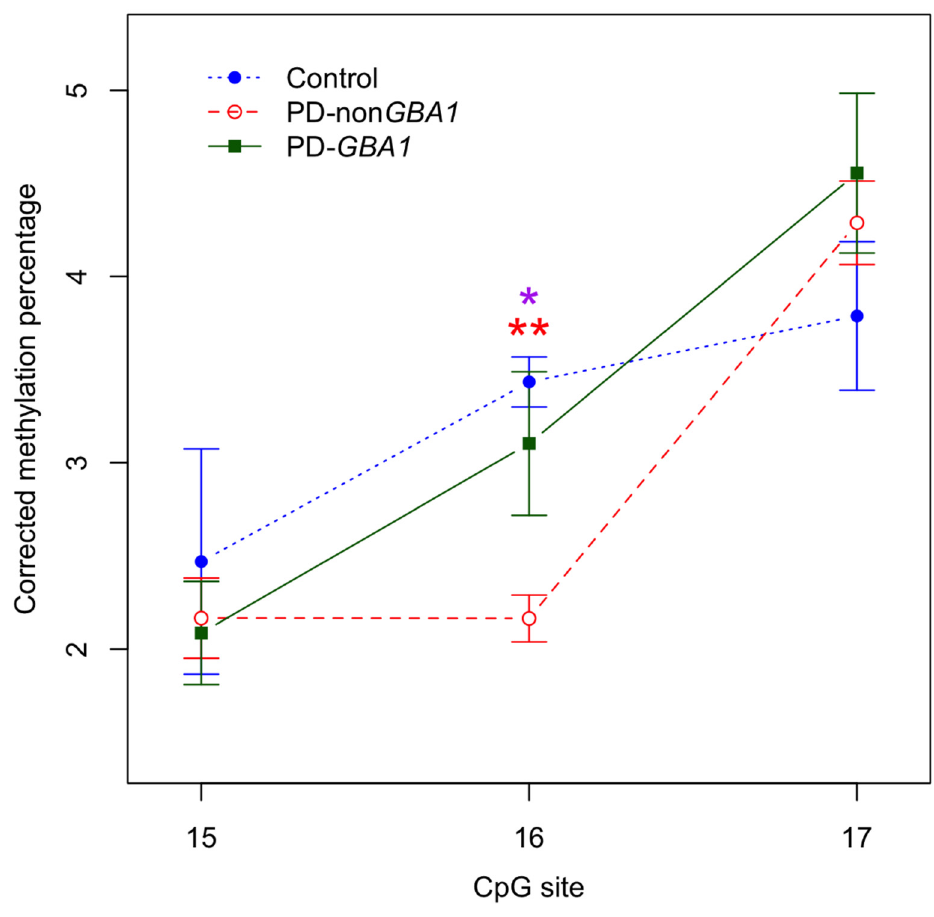
Figure 2. Significant DNA hypomethylation within the SNCA promoter in the substantia nigra in idiopathic PD. The methylation profile within the SNCA promoter in the substantia nigra shows significant decrease at CpG16 (red stars) for individuals with PD ‐ non GBA1 (red) compared to matched controls (blue). DNA methylation was also significantly lower at the same site (purple star) for individuals with PD ‐ non GBA1 (red) compared to PD ‐ GBA1 cases (green). n = 13 for PD ‐ non GBA1 , n = 6 for PD ‐ GBA1 , n = 3 for controls. Legend: ** = p < 0.01, * = p < 0.05, PD ‐ non GBA1 = idiopathic PD. Error bars–SD. Corrected methylation percentage adjusted for age and gender. Altogether, this points to the possibility that SNCA hypomethylation in the promoter might play a role in idiopathic PD, further highlighting the importance of analyzing idio ‐ pathic PD separately from PD ‐ GBA1 . However, it should be noted that this is based only on three CpG promoter sites and three non ‐ PD controls. Future analysis including more CpG sites and more controls is necessary before firm conclusions can be drawn. 3. Discussion This study provides the first measurement of DNA methylation of α‐ synuclein in individuals with Parkinson’s disease who carry GBA1 mutations. We considered three brain regions (the frontal cortex, putamen and substantia nigra) and also assessed DNA methylation levels in the corresponding brain regions of individuals with idiopathic PD. For the first time, this allowed us to determine whether SNCA DNA methylation shows a unified pattern across the brain in PD.